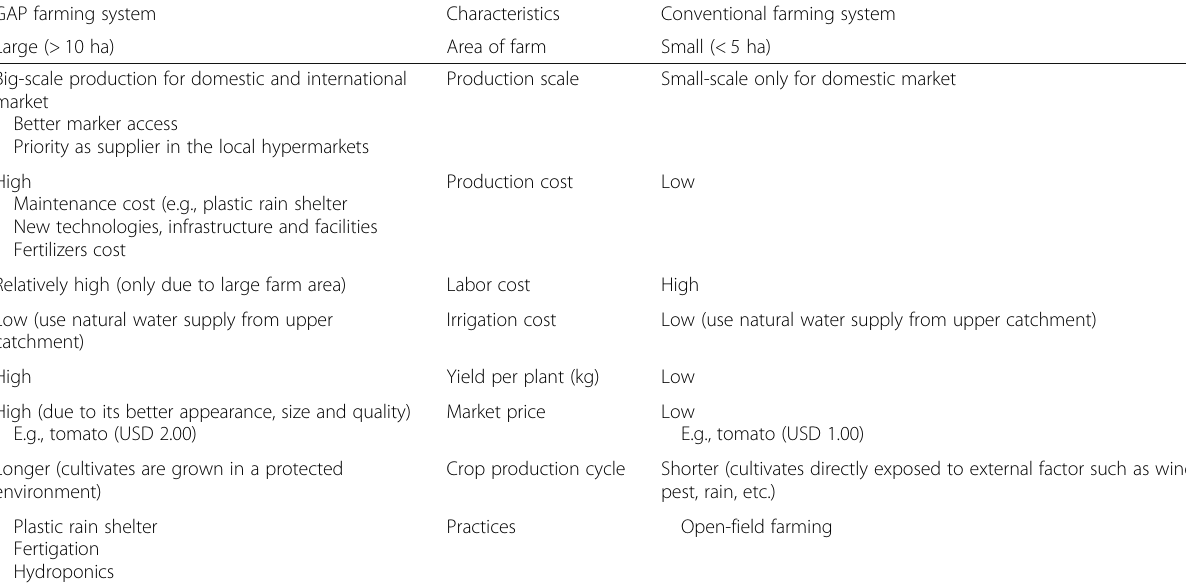
Table 2 The differences between agriculture farming system in Cameron Highlands (Tiraieyari et al. 2014; Radam et al. 2015) GAP farming